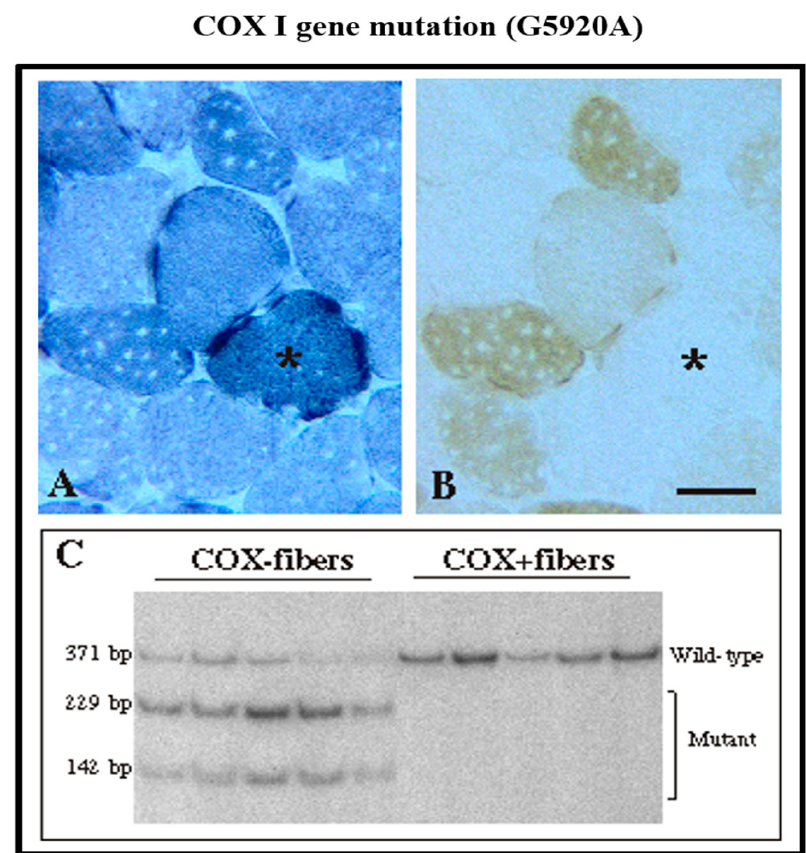
Figure 3. Evaluating the pathogenicity of a novel mtDNA mutation in single fibers by PCR. ( A ) Succinate dehydrogenase (SDH) staining; ( B ) Cytochrome c oxidase (COX) staining; ( C ) Analysis for a specific mtDNA mutation by PCR. In this young man with recurrent myoglobinuria, we identified a nonsense mutation in the COXI gene of mtDNA [13]. COX-negative (COX-) fibers are indicated by asterisks in A and B. The results of the PCR analysis in single fibers clearly show the high abundance of the mutation in COX- fibers and the lack of mutation in COX+ fibers.